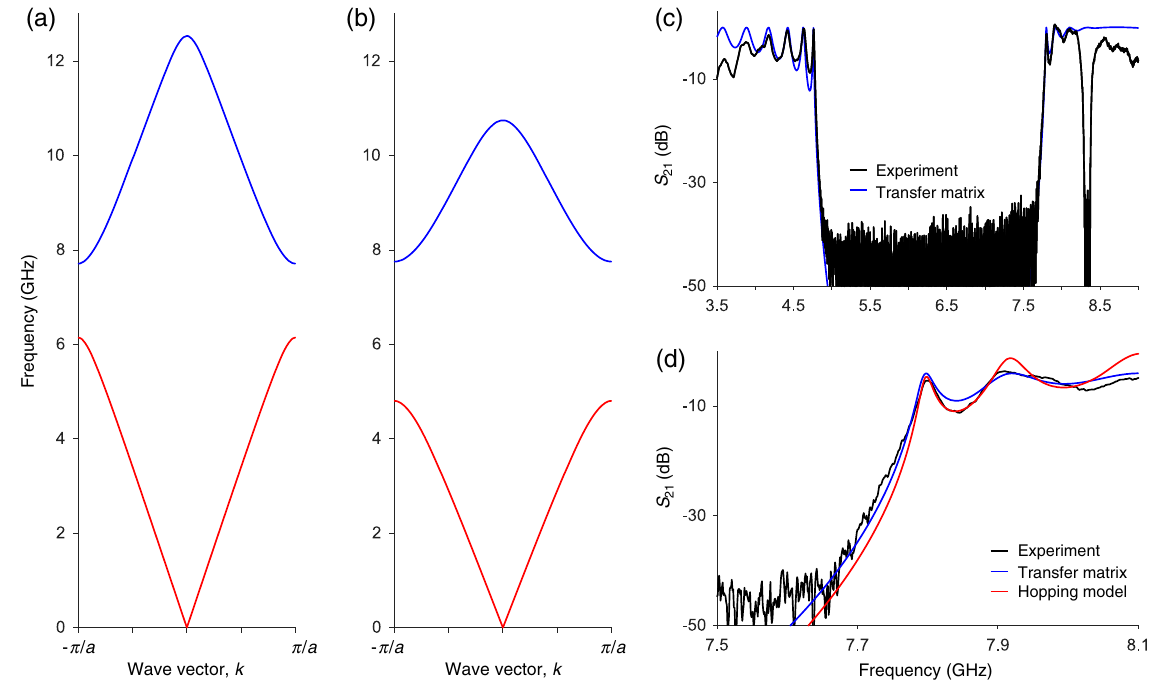
25 Ω , Z 124 Ω and (a) L 0 . 45 mm, L 8 mm (parameters from FIG. 5. First two bands of simulated dispersion for Z lo ¼ hi ¼ lo ¼ hi ¼ 1 . 2 mm, L 7 . 8 mm (parameters from present paper). (c) Overlay of simulated S [13]), and (b) L 21 from the transfer matrix lo ¼ hi ¼ method [blue; same parameters as (b)] and measured high-power S 21 (black) shows good agreement in bare crystal characteristics. (d) Overlay of simulated S 21 from the transfer matrix method [blue; same parameters as (b)] and from the hopping model [red; with κ ¼ 1 GHz and κ 4 MHz] and measured high-power S 0 ¼ 21 (black) near the band edge. Drop in transmission circa 8.3 GHz is due to TWPA dispersion, not device